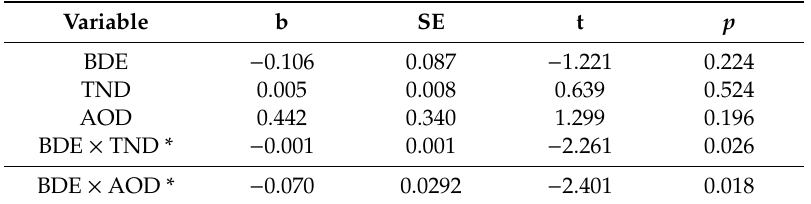
Table 6. Regression coe ffi cients from the moderation analysis: Slope of the linear regression (b), standard error (SE), and t statistic. The interactions between the predictor (BDE) and the two moderator variables (TND and AOD) were significant. * p < 0.05. SE